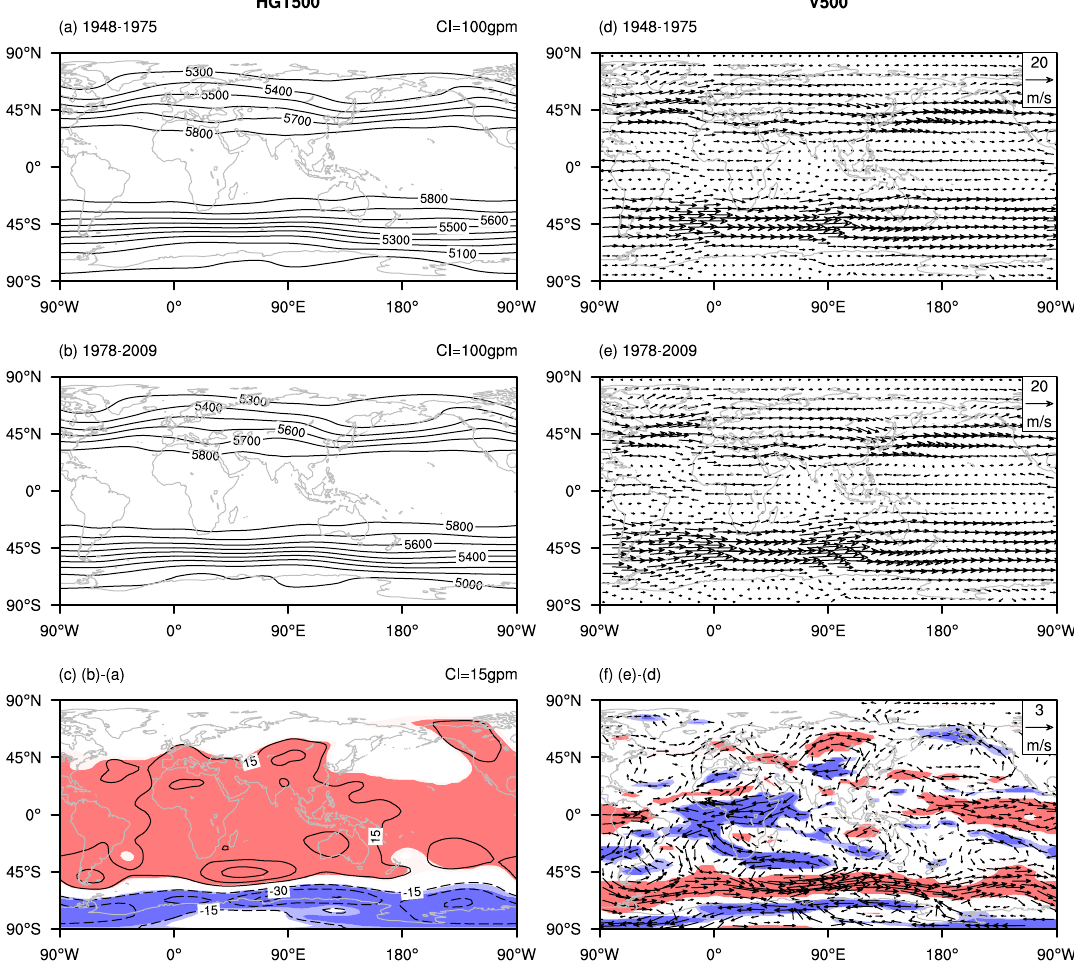
Figure 2. The annual mean 500 hPa geopotential height during the sub-periods ( a ) 1948–1975; ( b ) 1978–2009; and ( c ) their difference (i.e., ( b ) minus ( a )); ( d – f ) are the same as ( a – c ), but for the annual mean 500 hPa winds. Negative values are dashed, and zero contours are omitted in ( c ). Dark and light shading indicates 99% and 95% confidence levels based on two-tailed Student’s t -test, respectively. Zonal winds are used to evaluate the confidence level in ( f